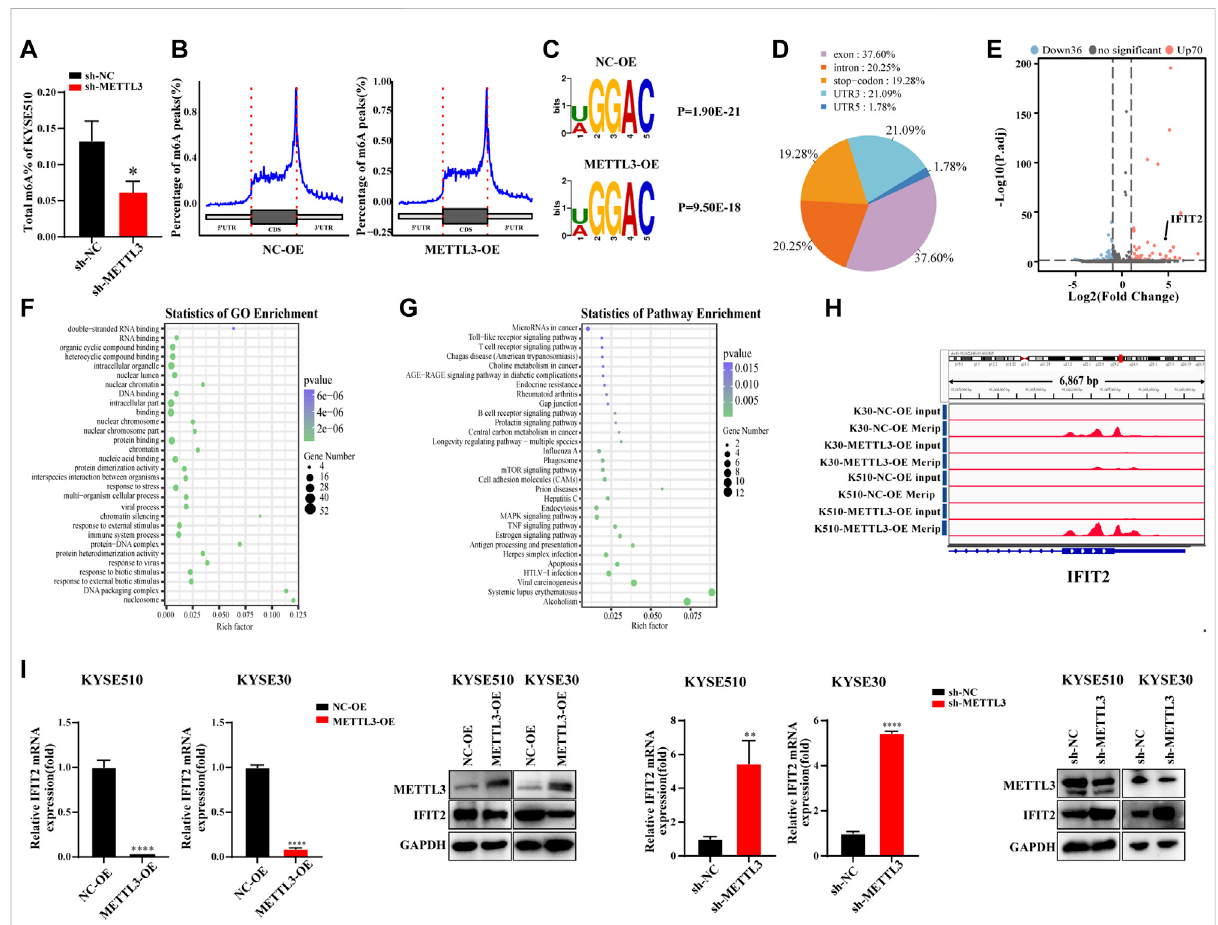
MeRIP-seq analysis of the effect of overexpression on the methylation of target genes (A) . The m 6 A RNA methylation assay revealed the m 6 A contentinKYSE510cellswithMETTL3 (B) .PeakdistributioninCDS,5 ′ UTRand3 ′ UTRregions(TheabscissaistheCDS,5 ′ UTR,and3 ′ UTRregions,and the ordinate is the distribution ratio of the peaks corresponding to the positions of each region). (C) . The predominant consensus motif GGAC was detected in m6A-seq. (D) . Statistical results of the regional distribution of the difference peak. (E) . The volcano plot shows the distribution of differential genes. (F) . The results of GO biological process enrichment. (G) . The results of KEGG pathways analysis. (H) . m 6 A peaks were enriched from m 6 A RIP-seq data. (I) . Effects of METTL3 overexpression or knockdown on IFIT2 mRNA and protein expression in KYSE510 and KYSE30